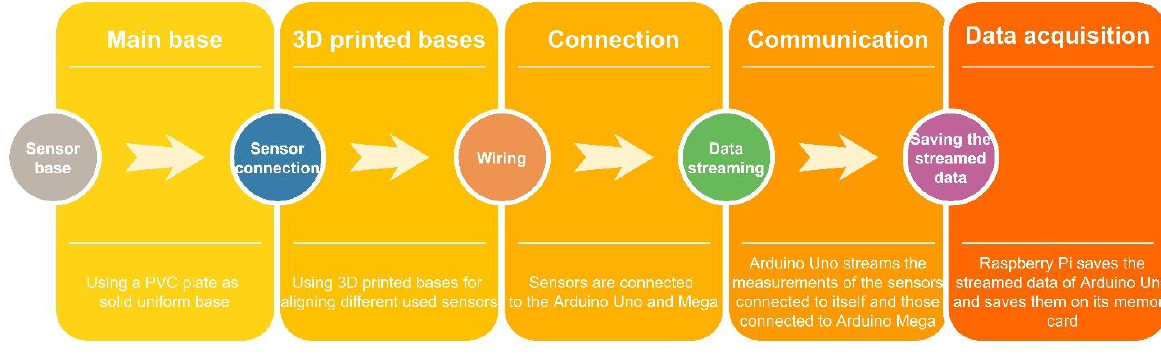
Figure 5. The components of the distance measuring device: ( a ) PVC sheet for attaching the sensors and the data acquisition equipment, ( b ) designed 3D-printed base for holding the various sensors together at a known height, ( c ) sensor allocation, ( d ) wiring the system together, ( e ) the experiment platform for validating the accuracy of several different low-cost sensors and ( f ) flowchart of the construction of the proposed measurement device.